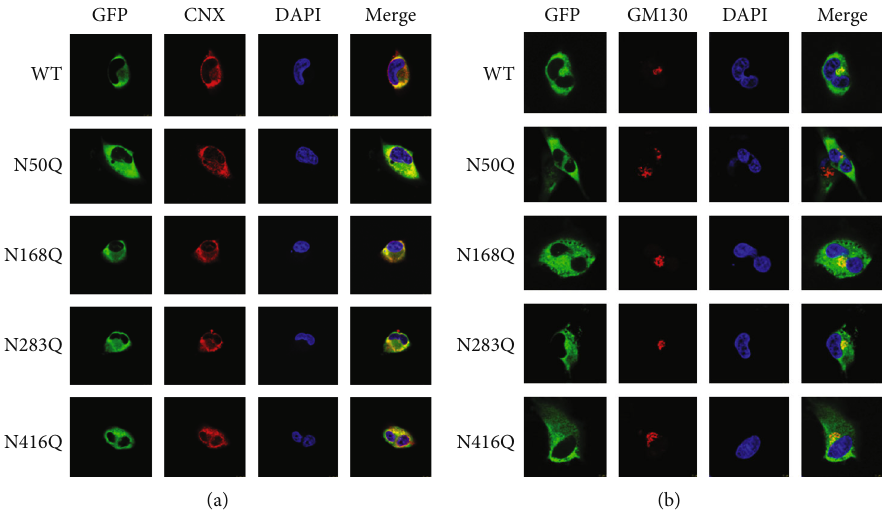
Figure 3: Subcellular localization of SND1 N-glycosylation mutants. (a) The localization of WT-SND1-EGFP and its four N-glycosylation mutants (green), CNX (red), and DAPI (blue) in U87 cells. (b) Immunostaining for WT-SND1-EGFP and its four N-glycosylation mutants (green), GM130 (red), and DAPI (blue) in U87 cells. Scale bar, 10 μ